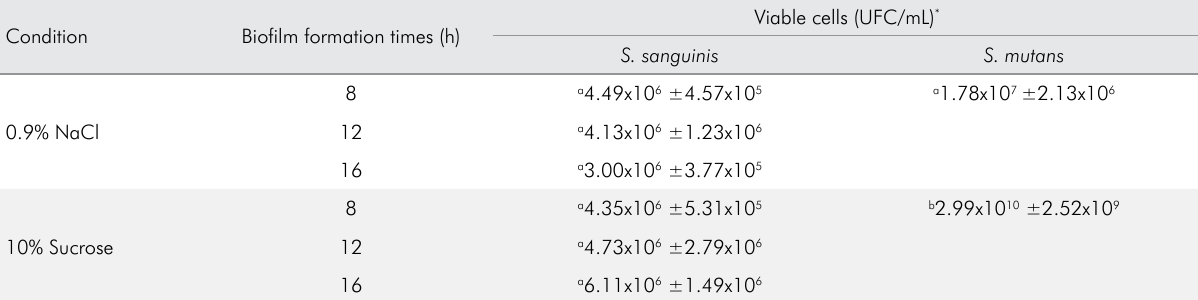
Table 2. Bacterial counts after exposure of dental enamel to different biofilm formation times in the presence/absence of sucrose for S. sanguinis and S. mutans